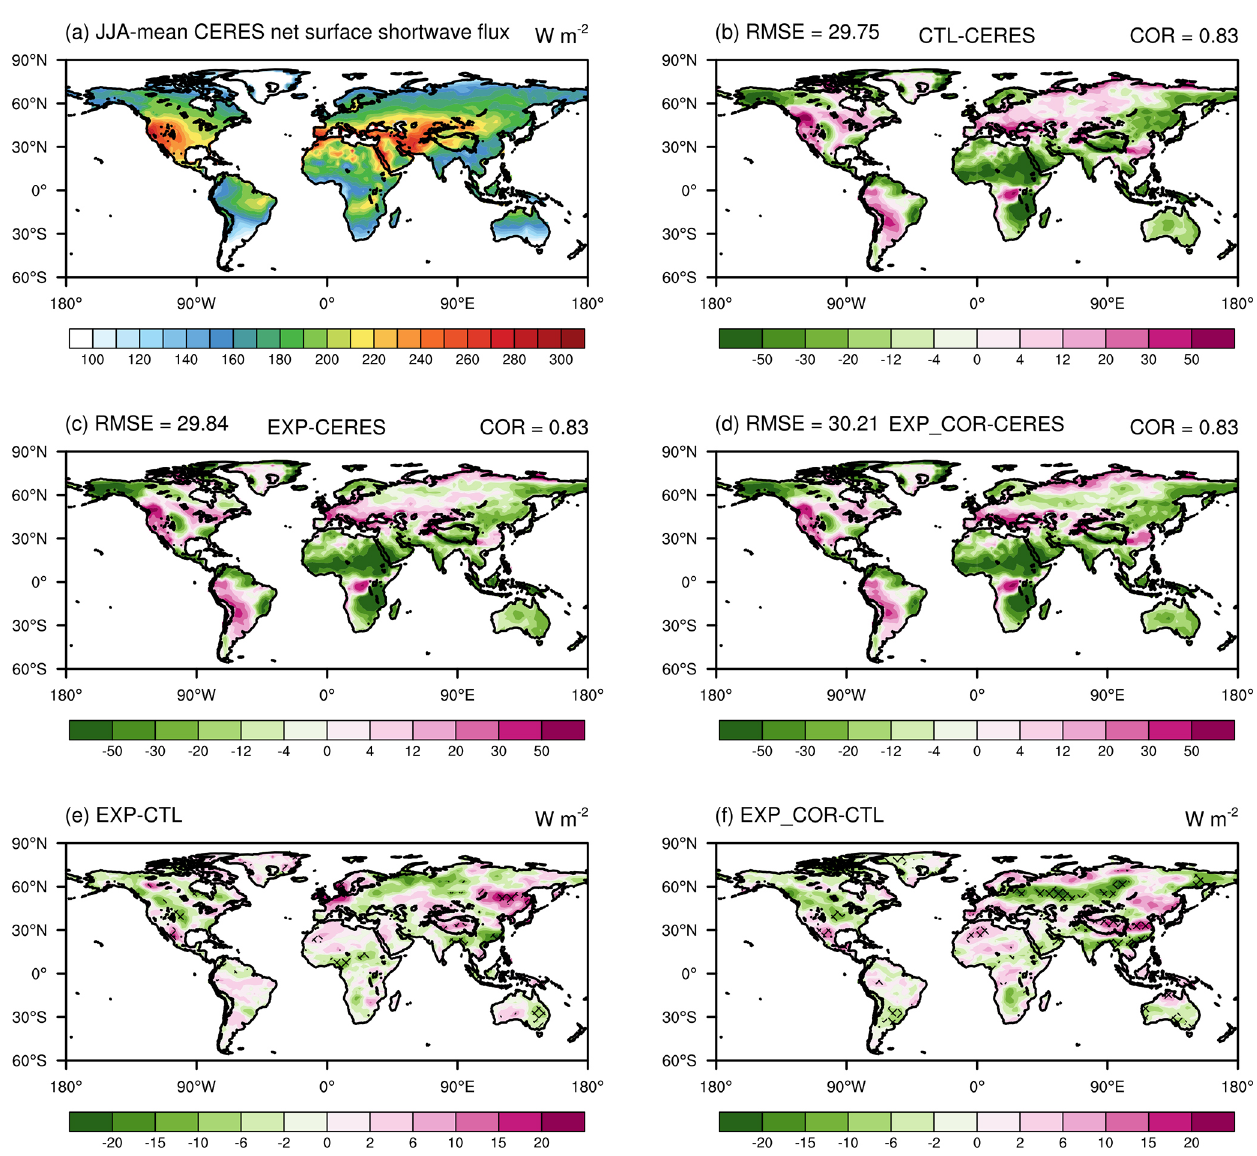
Figure 11. Spatial distributions of the JJA-mean net surface shortwave flux in (a) CERES-EBAF (downward positive); the biases of (b) CTL, (c) EXP, and (d) EXP_COR with respect to CERES-EBAF; and the differences (e) between EXP and CTL and (f) between EXP_COR and CTL. The crossed areas are significant at the 95% level. The averaged spatial COR and RMSE values for the three simulations are given in (b) – (d)